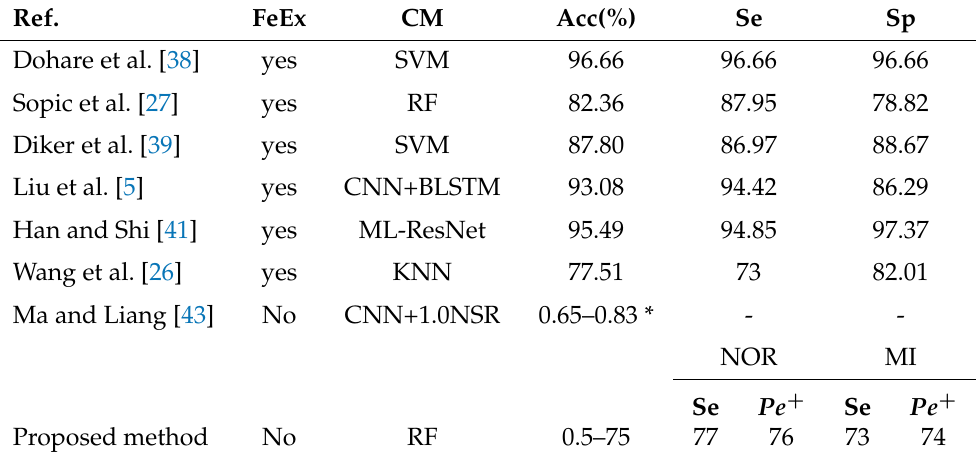
Table 8. Comparison with other works in the